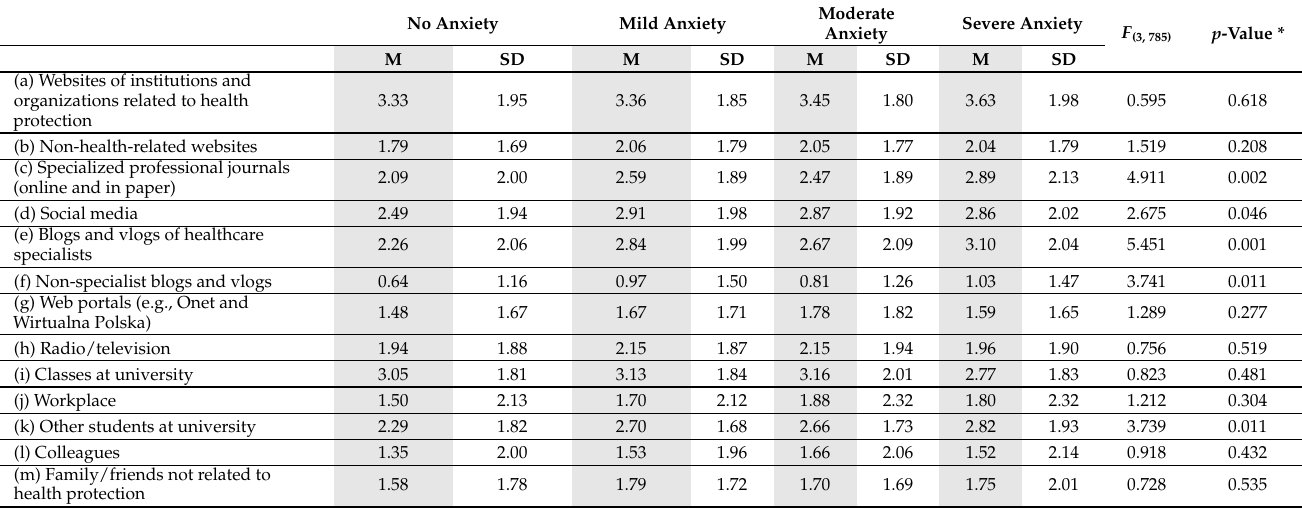
Table 4. Frequency of use of sources of information on vaccination and anxiety levels. No Anxiety Mild Anxiety